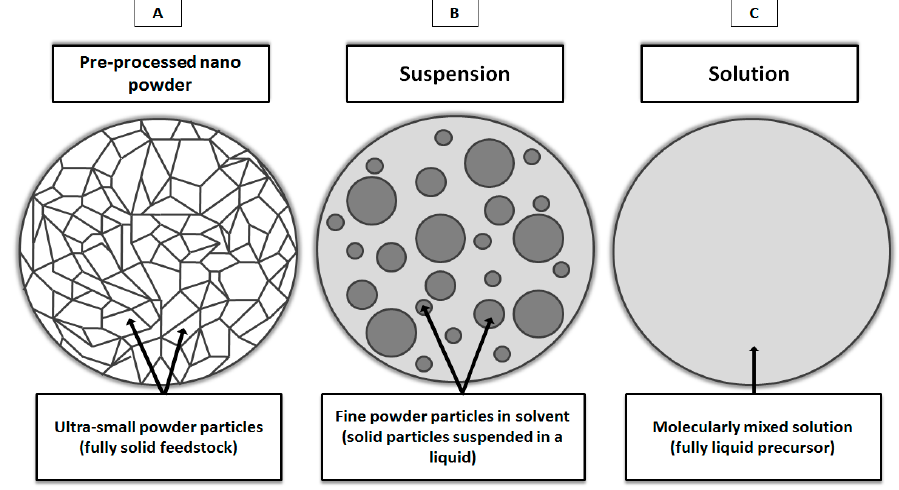
Figure 1. Feedstocks used for thermal spraying processes which enable to obtain nano-structured coatings: ( A ) the pre-processed nano-powder particle used for the APS process; ( B ) the suspension droplet used for the SPS process; and ( C ) the homogeneously-mixed solution droplet used for SPPS process.